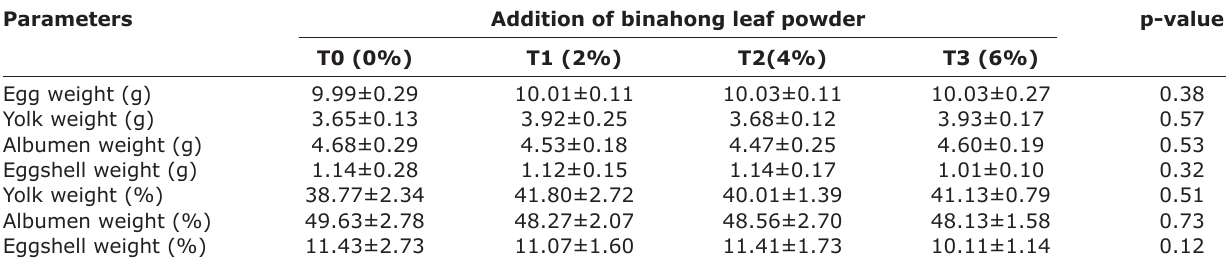
Table-4: Influence of addition of binahong leaf powder on quail eggs characteristic.